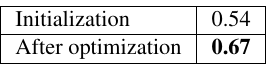
Table 2. Model Coverage. Intersection-over-union (IOU), aver- aged over all foreground objects before and after